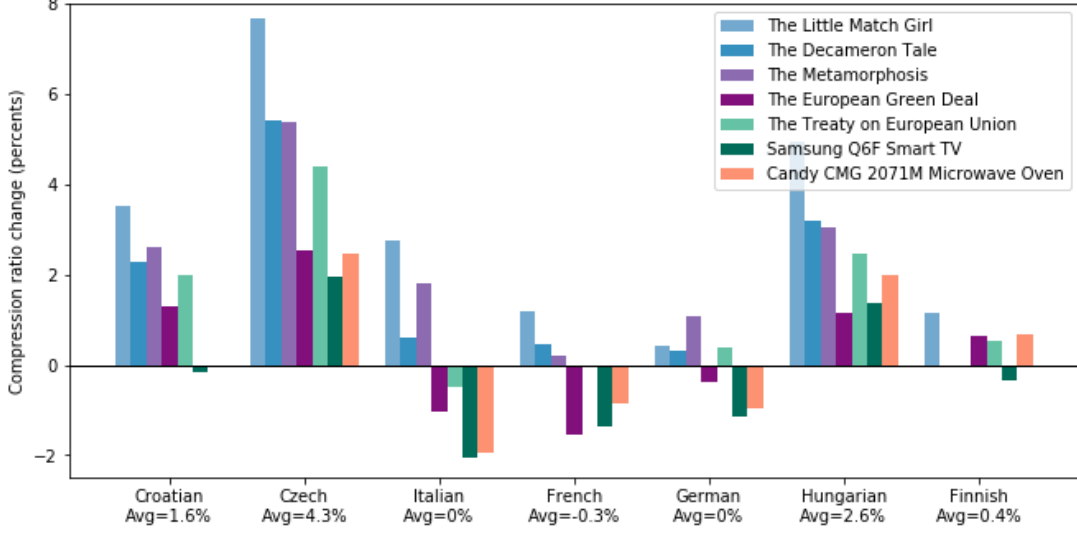
Figure 13. Compression ratio change compared to English—LZW compression (positive percentages signify larger compressed file size when compared to English).